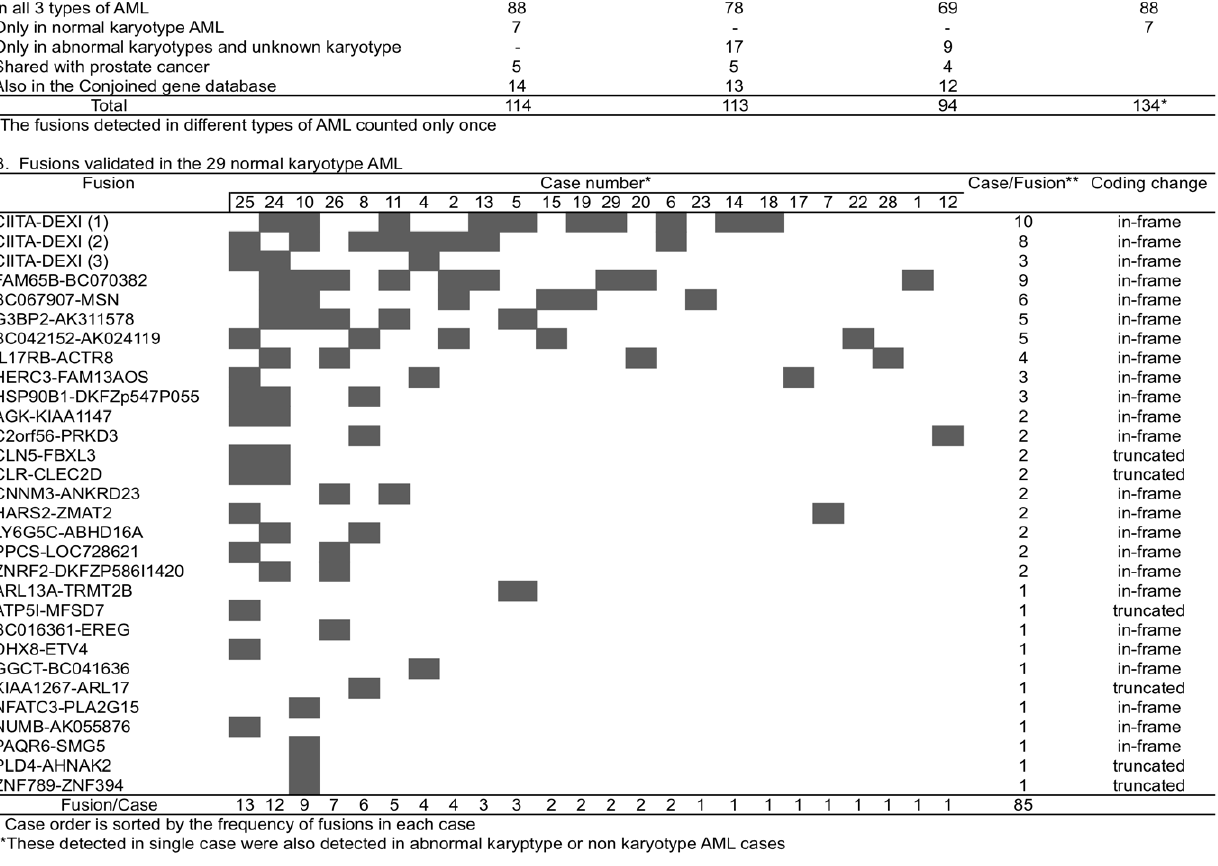
Figure 2. Fusion transcript information. A. Fusion transcripts identified in different types of AML. B. Validated fusion transcripts identified in normal karyotype